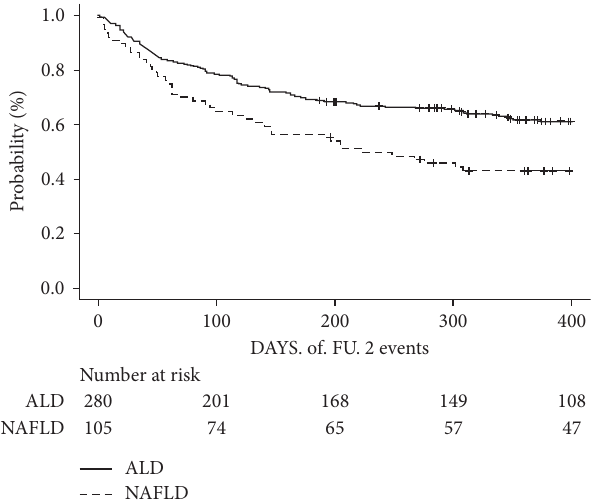
Figure 2: Adjusted Cox model for the probability of transplant-free survival in NAFLD cirrhosis (dotted line) and ALD cirrhosis (solid line). NAFLD HR � 1.9 (95% CI